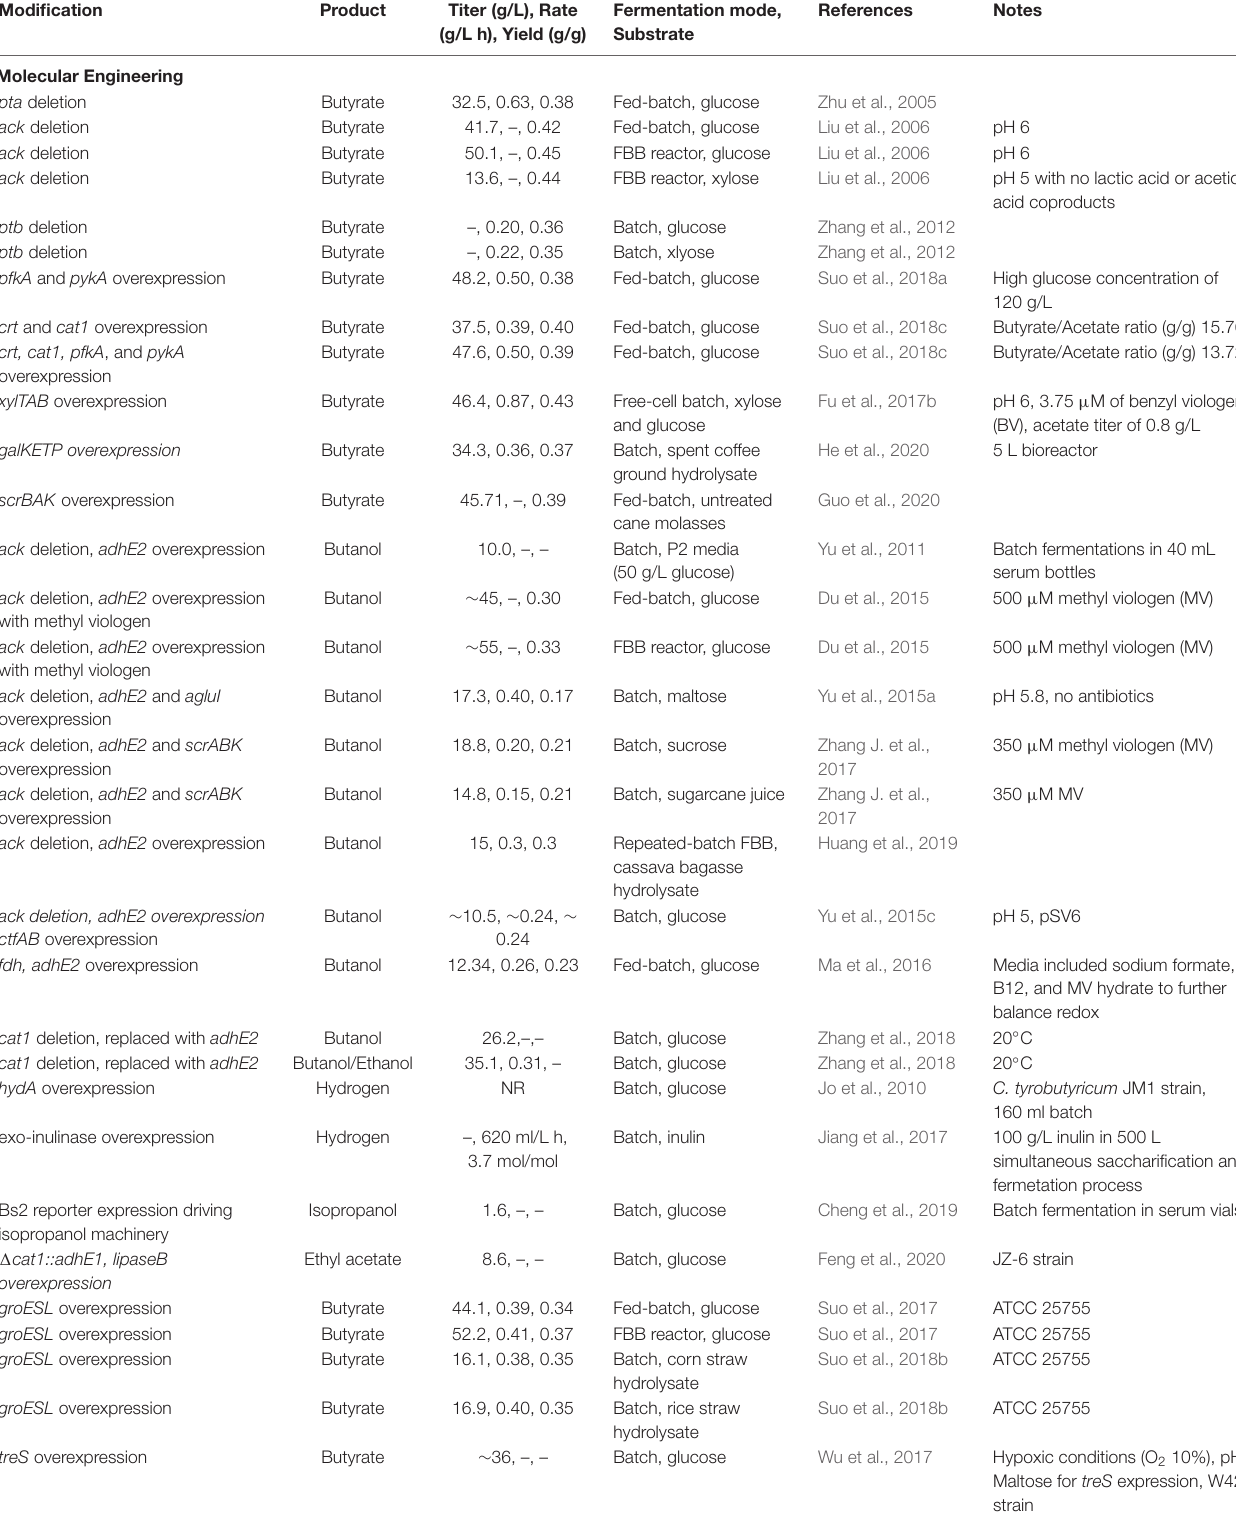
TABLE 1 | Engineering strategies to enhance C. tyrobutyricum